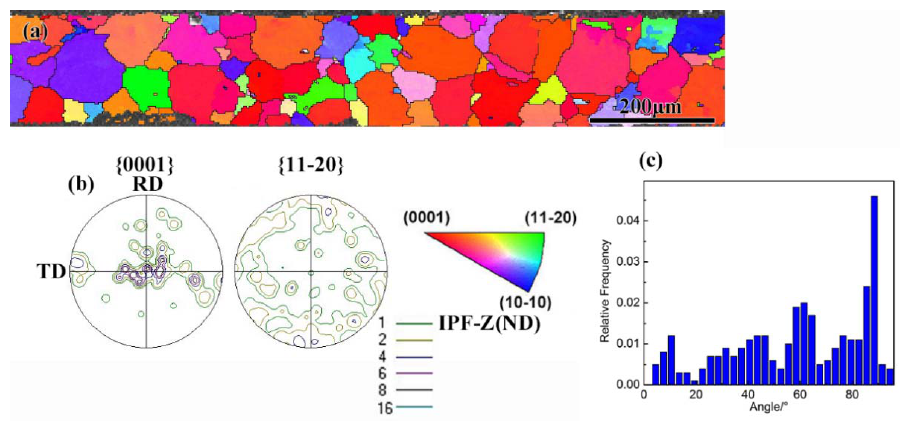
Figure 7. ( a ) Orientation map, ( b ) pole figures, and ( c ) misorientation of warm ‐ rolled sample with 90% reduction following annealing at 1000 °C under Ar atmosphere and cooled with water.